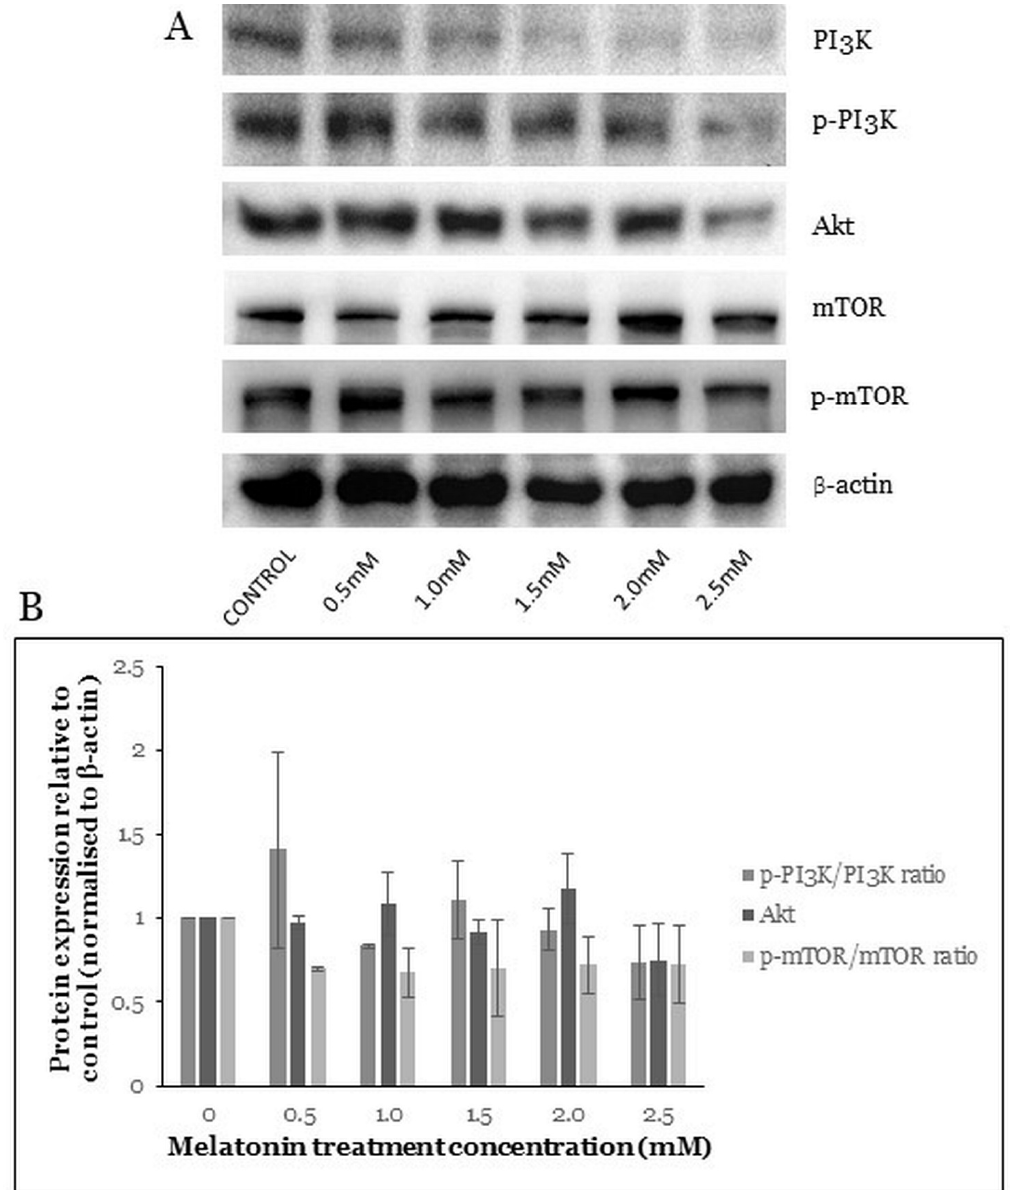
Figure 6. Western blot analysis of the PI3K/Akt/mTOR pathway in HT-29 cells after treated with various concentrations of melatonin for 72 h. ( A ) Expression levels of PI3K/Akt/mTOR proteins were assessed by Western blot analysis. ( B ) Bar chart of protein expressions; each bar represents a mean ± SEM of three independent experiments. One-way ANOVA, followed by Dunnett’s post hoc test, was performed to compare each treatment group with